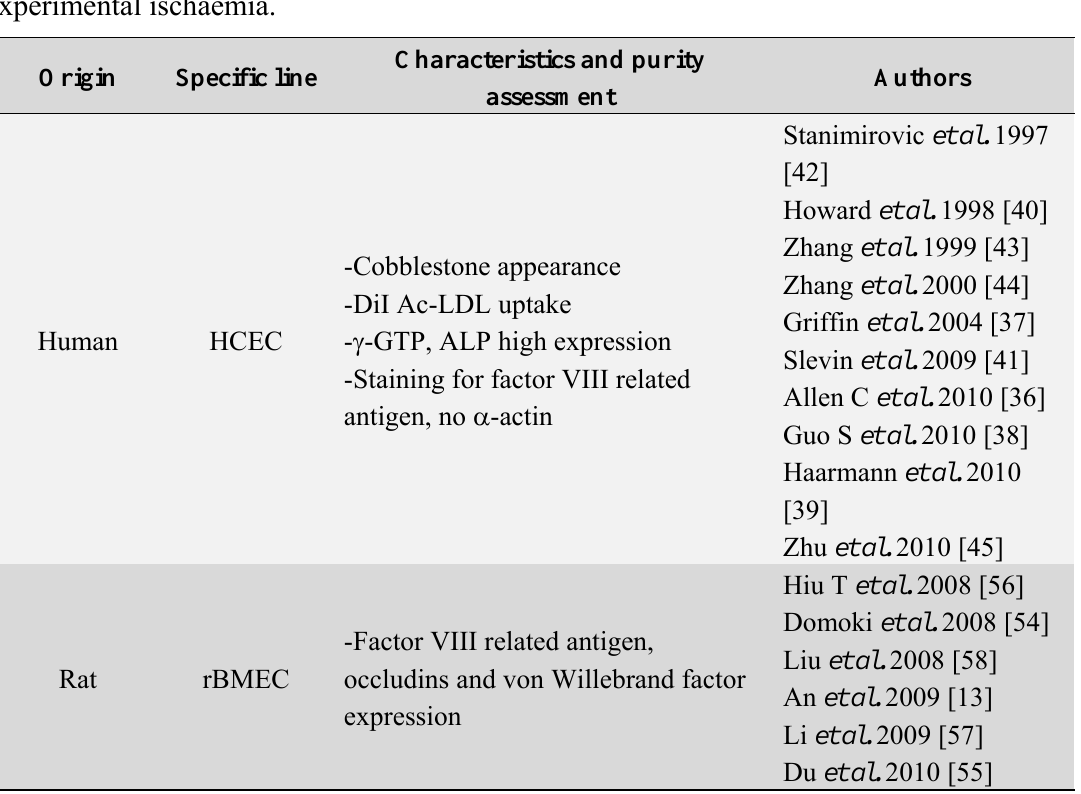
Table 3A. Studies performed with primary brain endothelial cells submitted to experimental